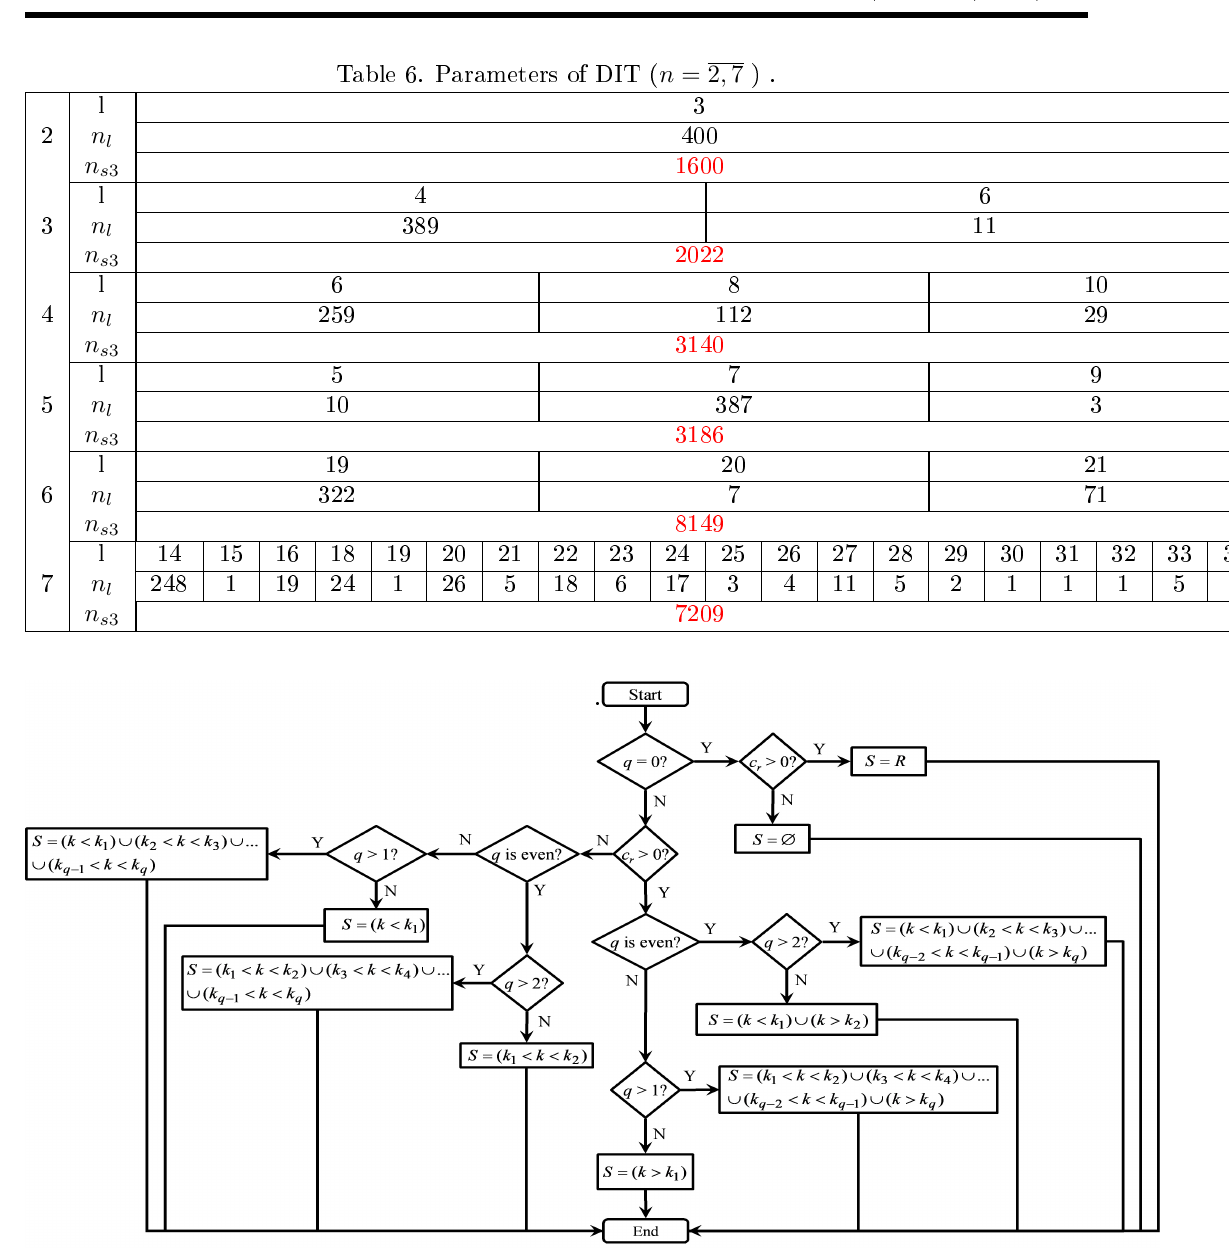
Fig. 3: Algorithm for solving the polynomial inequality P ( k ) > 0 . .